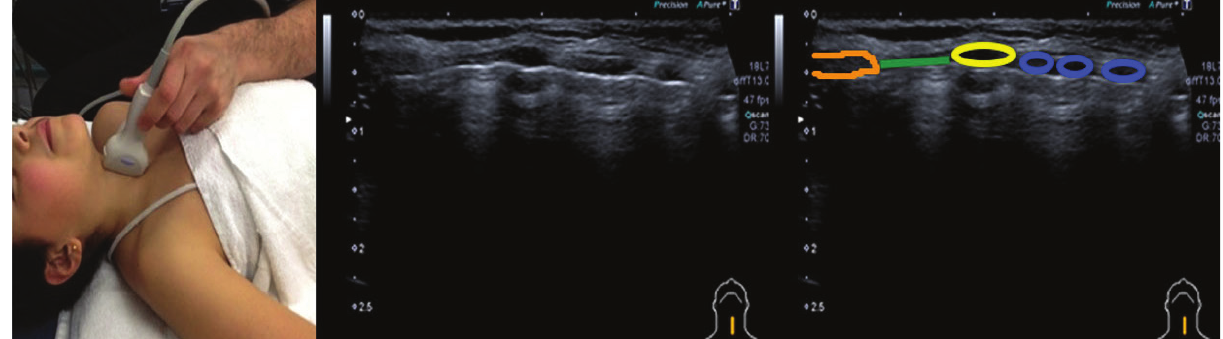
Figure 8. Ultrasound of the longitudinal view of the trachea Thyroid cartilage (orange), CTM (green), cricoid cartilage (yellow), tracheal rings (blue)